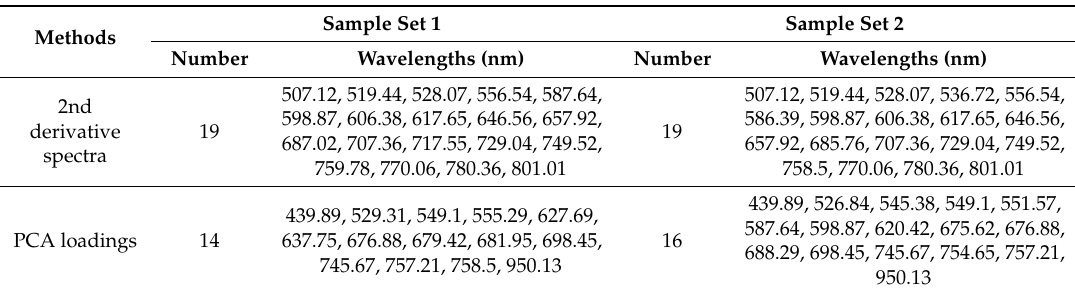
Table 4. Optimal wavelengths selected by 2nd derivative spectra and the PCA loadings of sample set 1 and 2 using pixel-wise spectra.